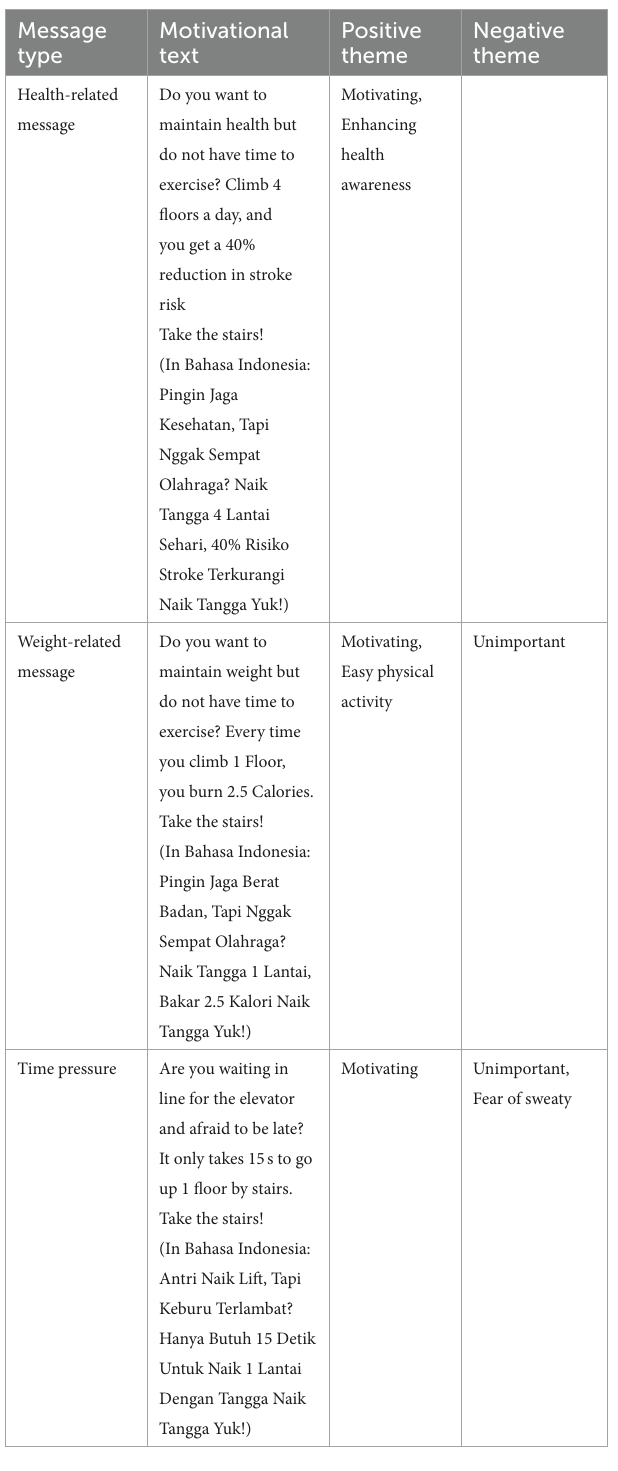
TABLE 2 Employees’ opinions on motivational texts.